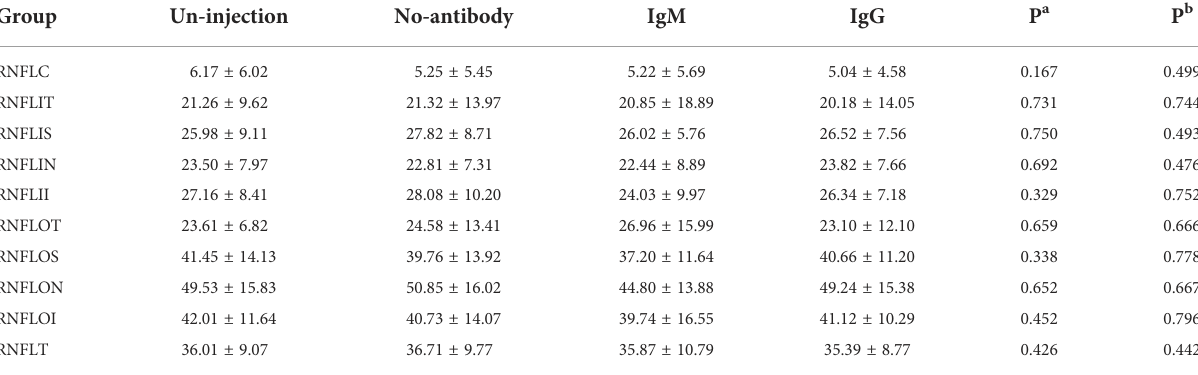
TABLE 5 Analysis of retinal nerve fi ber layer thickness in age-related cataract patients with different COVID-19 antibody statues (median ± IQR, m m).